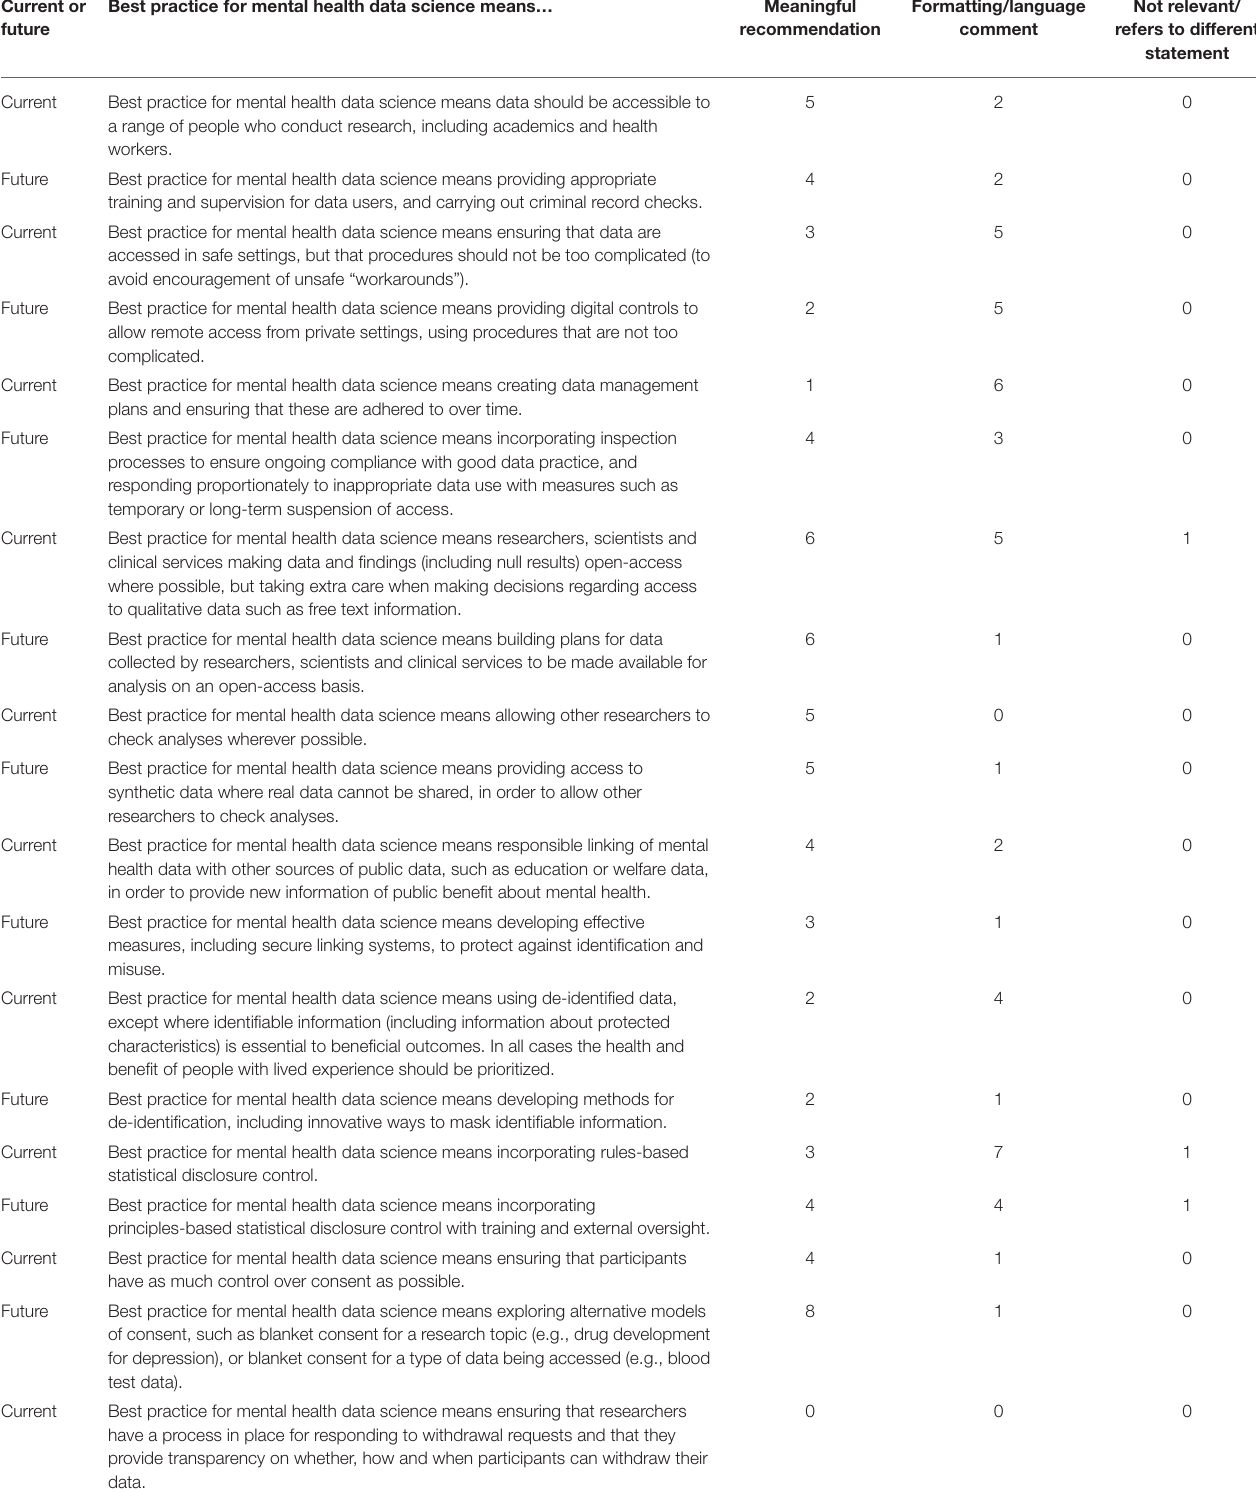
TABLE 4 | Phase 2 survey components with their corresponding number of participant comments, divided by comment